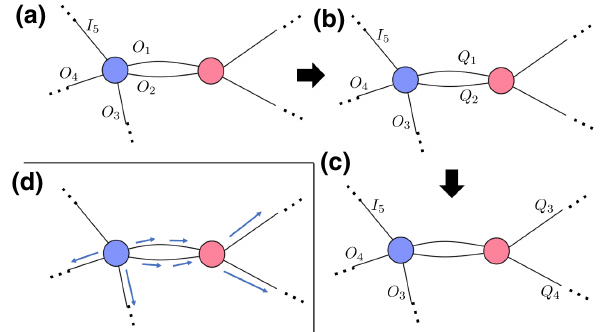
FIG. 2. Consider two tensors adjacent to each other in a larger tensor network. (a) To find the UPS of a larger network, one inserts a UPS for a local tensor (blue), and (b) pushes it to the matching operators Q 1 , Q 2 over connected edges. Then Q 1 , Q 2 are pushed to the remaining legs of the adjacent tensor (pink) using the UPS of the pink tensor (c). (d) The whole process may be denoted as an operator flow, where the sequence of matching and pushing nonidentity local operators are denoted by arrows along the